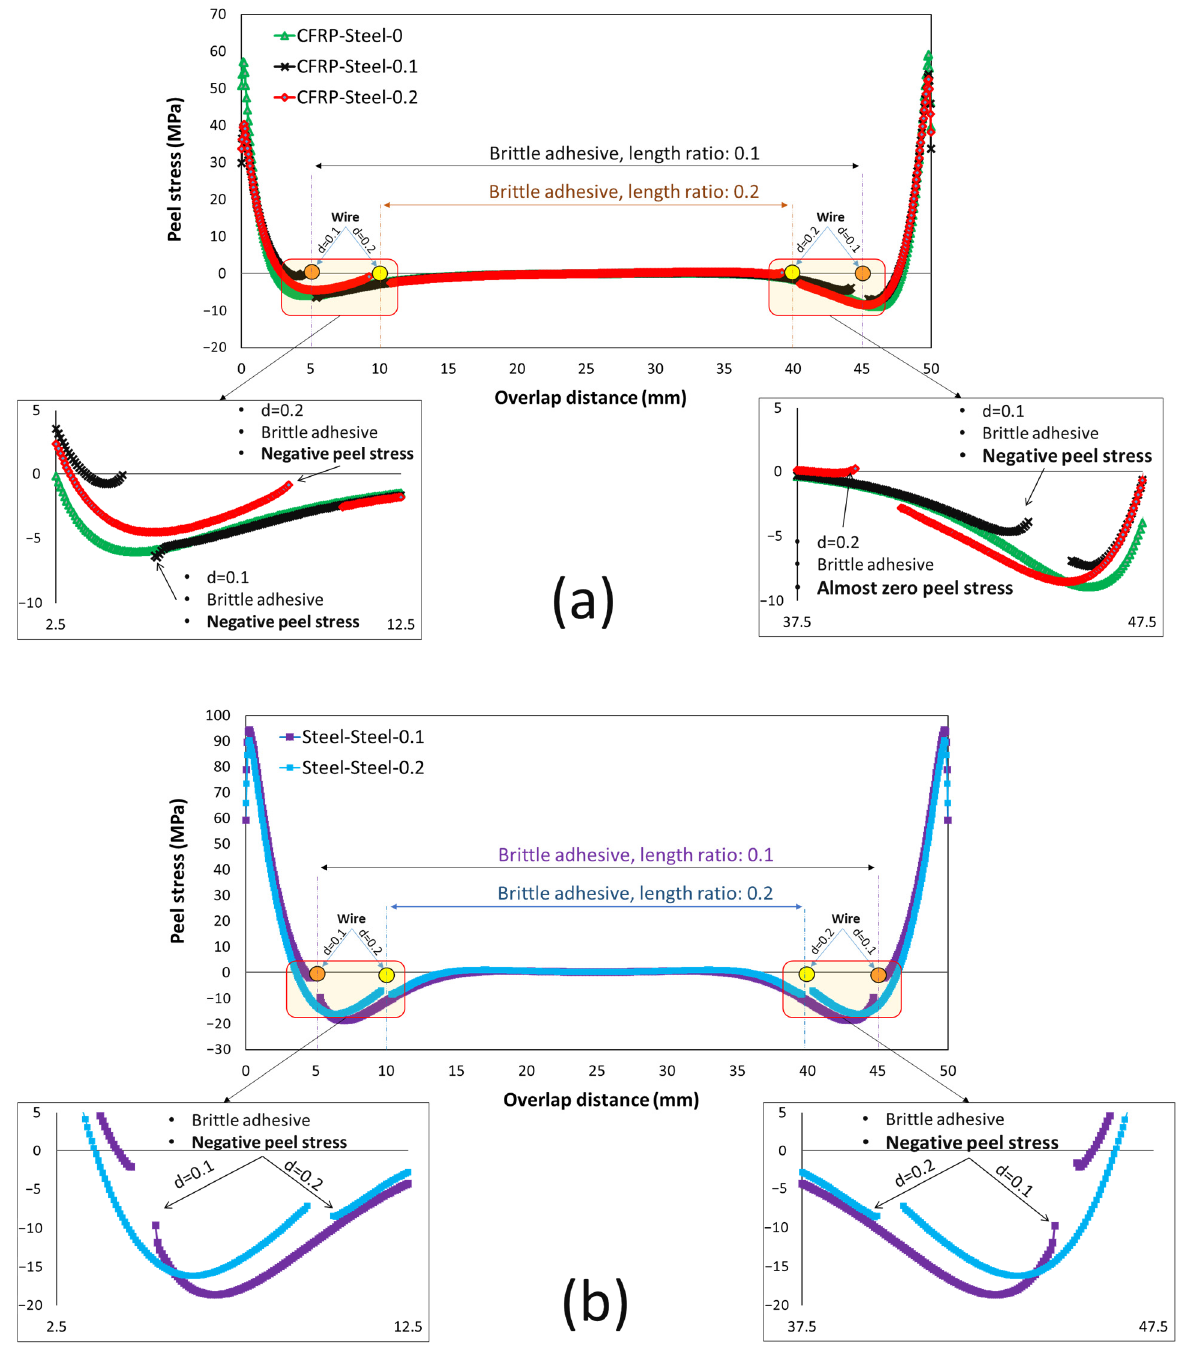
Figure 6. Normal stress distribution along the bondline in the tested bi-adhesive SLJs ( a ) dissimilar CFRP-Steel and ( b ) similar steel joints.